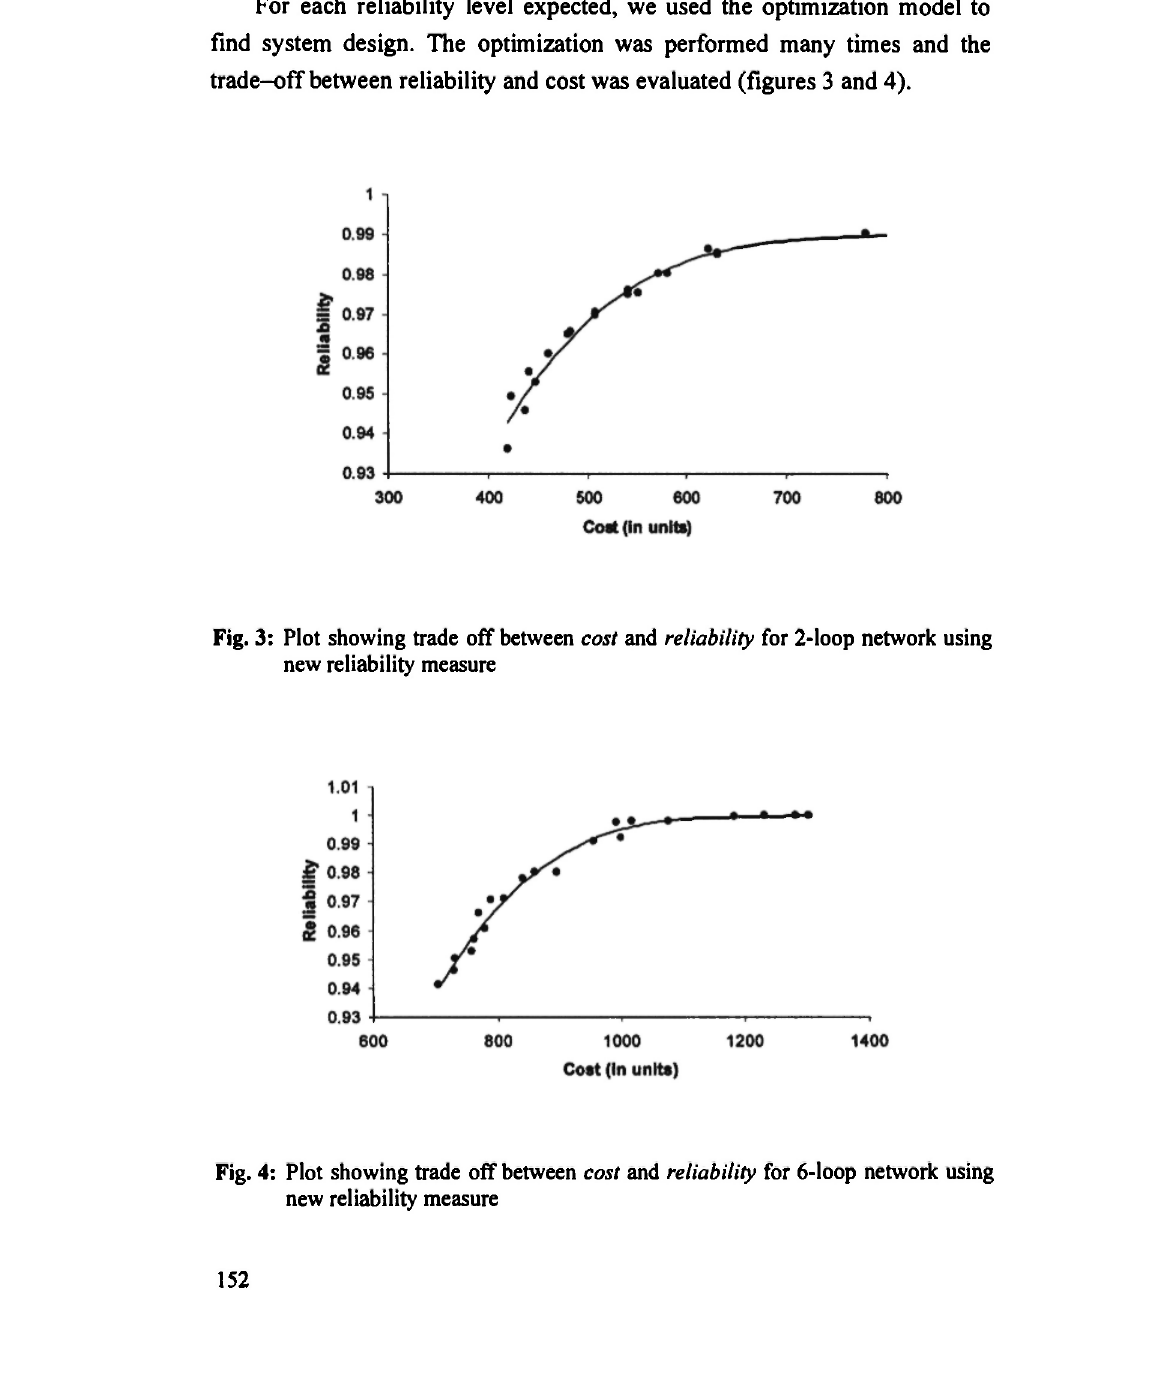
Fig. 4: Plot showing trade off between cost and reliability for 6-loop network